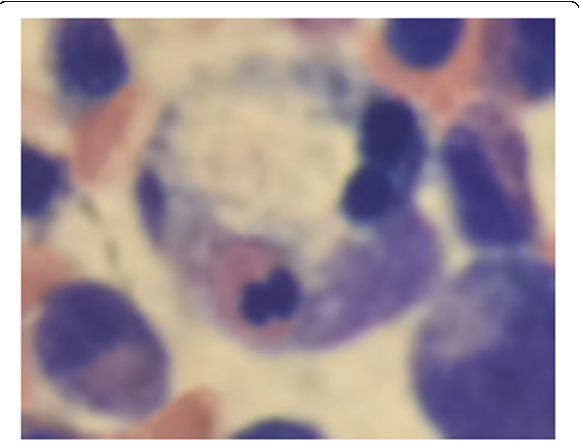
Fig. 2 Hemophagocytic cells detected in bone marrow